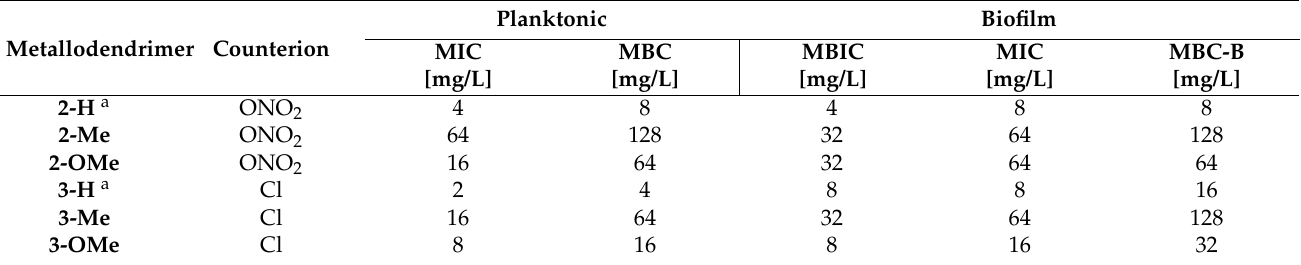
Table 3. Bacteriostatic and bactericide effect of first-generation carbosilane Cu(II) metallodendrimers in S. aureus planktonic cells (MIC, MBC) and biofilm-forming cells (MBIC, MIC, MBC-B).